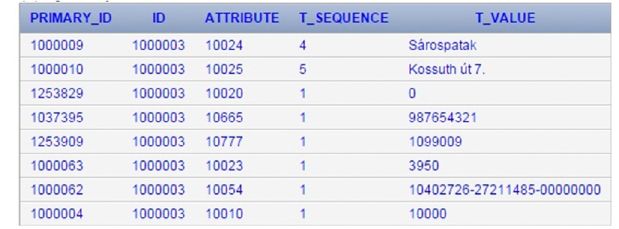
Figure 10. New entity.